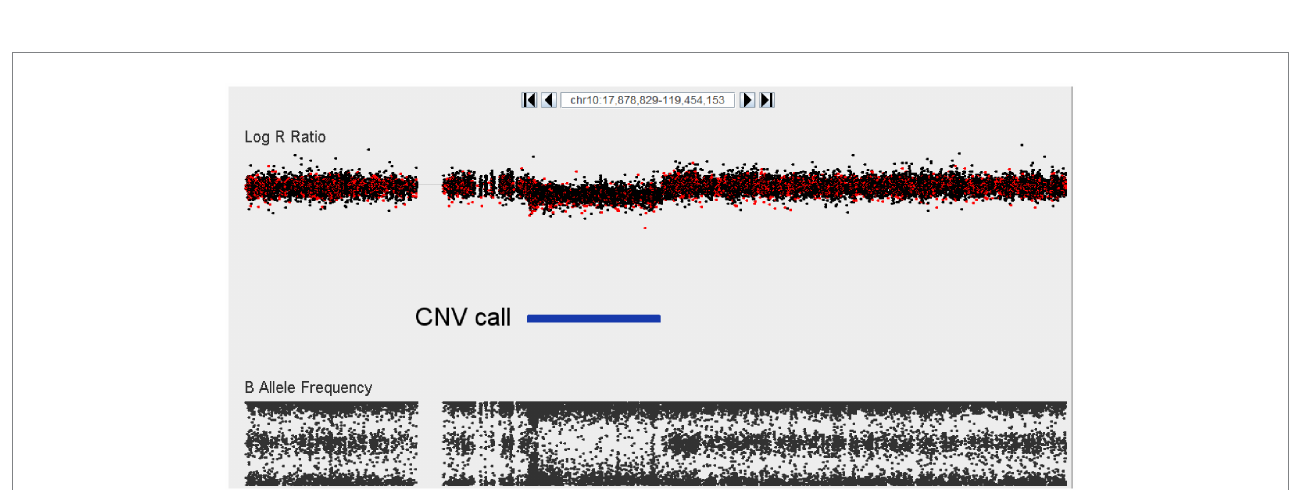
FIGURE 3 Visualization of a 16.5 Mb deletion at chromosome 10 (52,931,142–69,418,051) encompassing at least 68 different genes. The top panel depicts logR ratio data (signal intensity) and the bottom panel depicts the B-allele frequency (ratio of minor to major alleles). Dots indicate the location of SNPs on the array. CNV calls made using the Genvisis algorithm are indicated using the blue colored bar between the